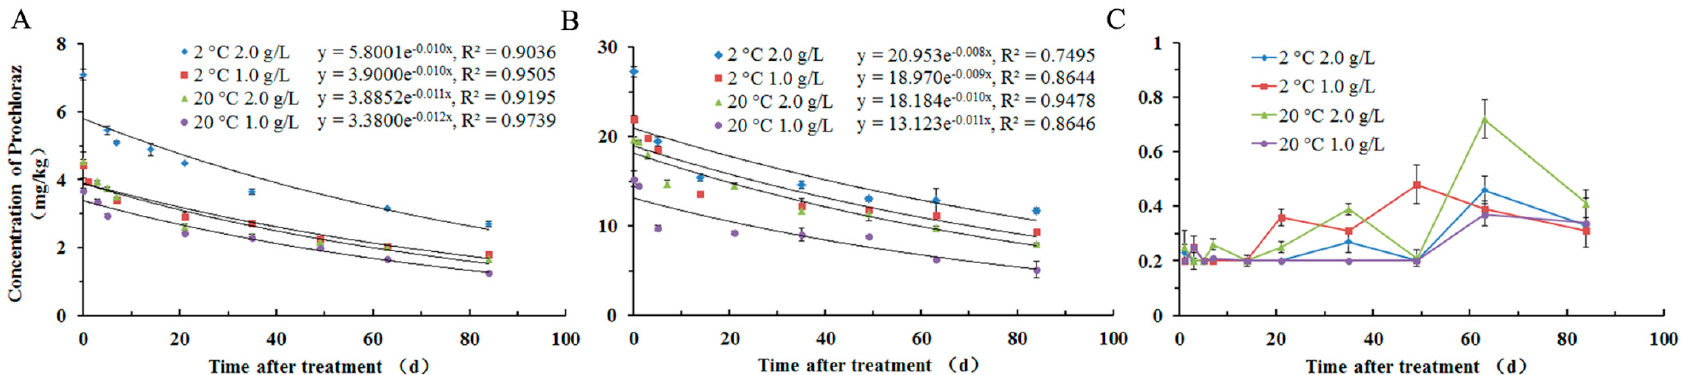
Figure 1. Residual dynamics of Prochloraz in apple under different treatment concentrations ( n = 3). ( A ) Whole fruit; ( B ) apple peel; ( C ) apple pulp.